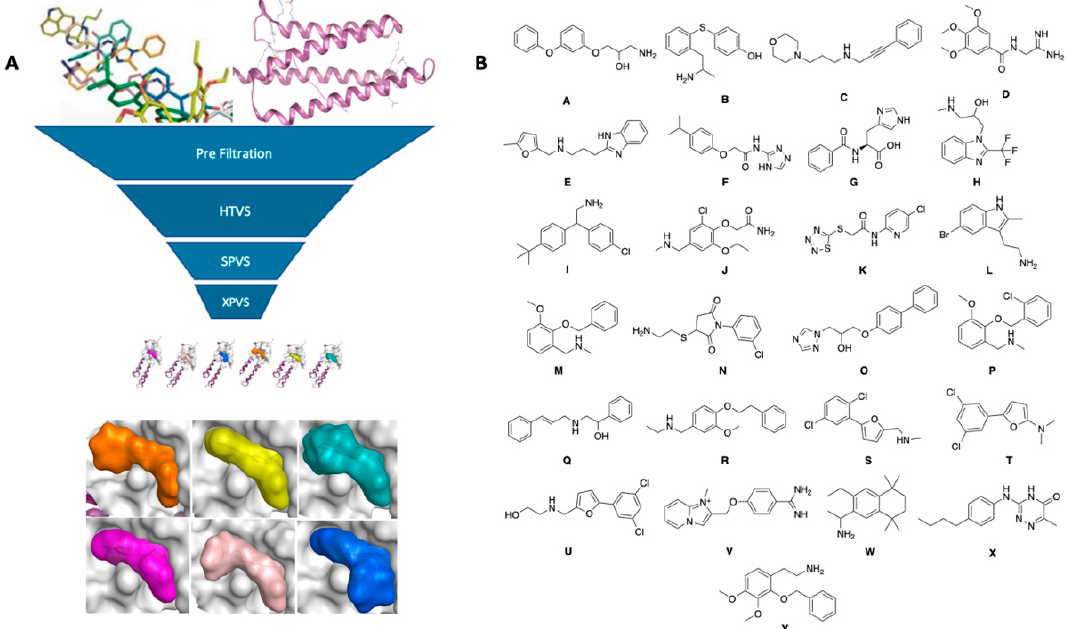
Figure 2. ( A ) Schematic representation of the virtual screening of SPECS virtual library against FAK-FAT domain. ( B ) Chemical structures of the top 25 preliminary FAK-FAT hits in the virtual screening experiment.